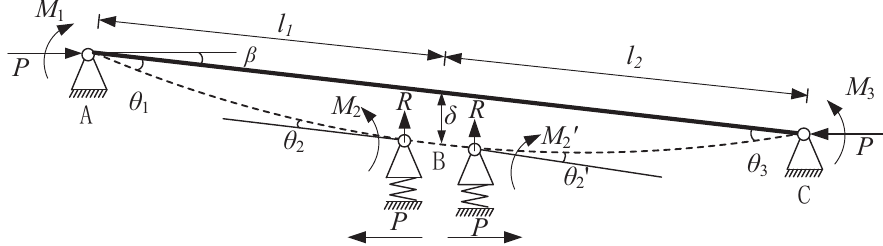
Fig. 2. Chord member simpli fi ed model and loading